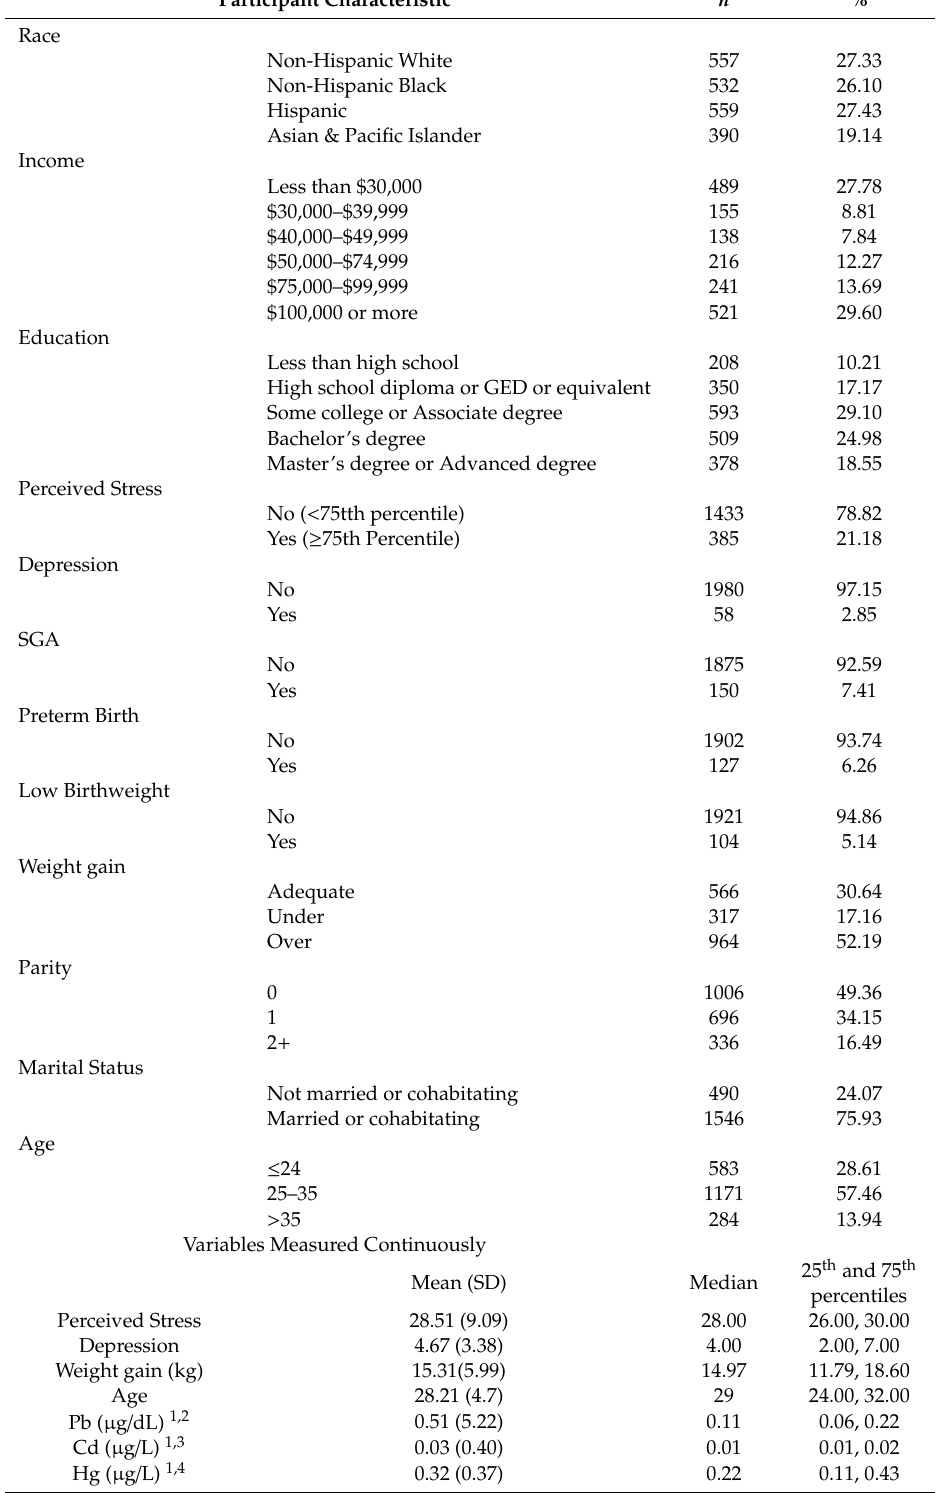
Table 1. Population characteristics, The Fetal Growth Study ( n =